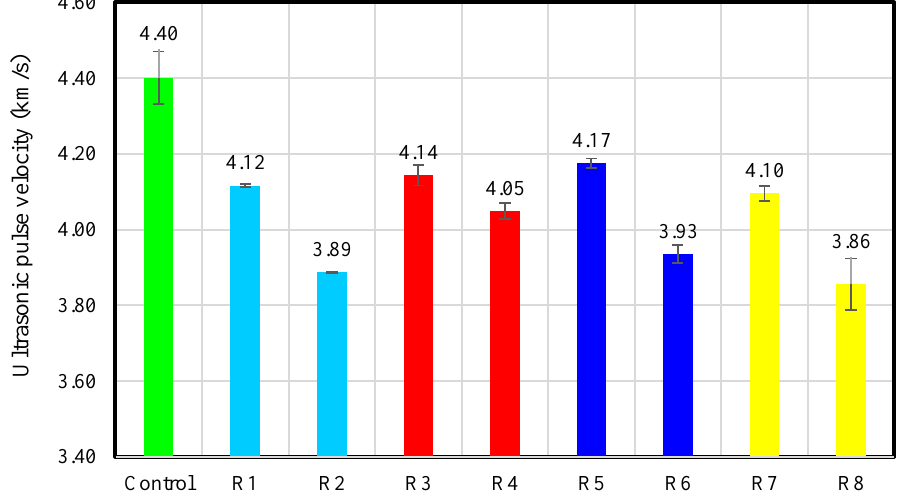
Figure 24. Variation of ultrasonic pulse velocity with different combinations of recycled plastic aggregates.